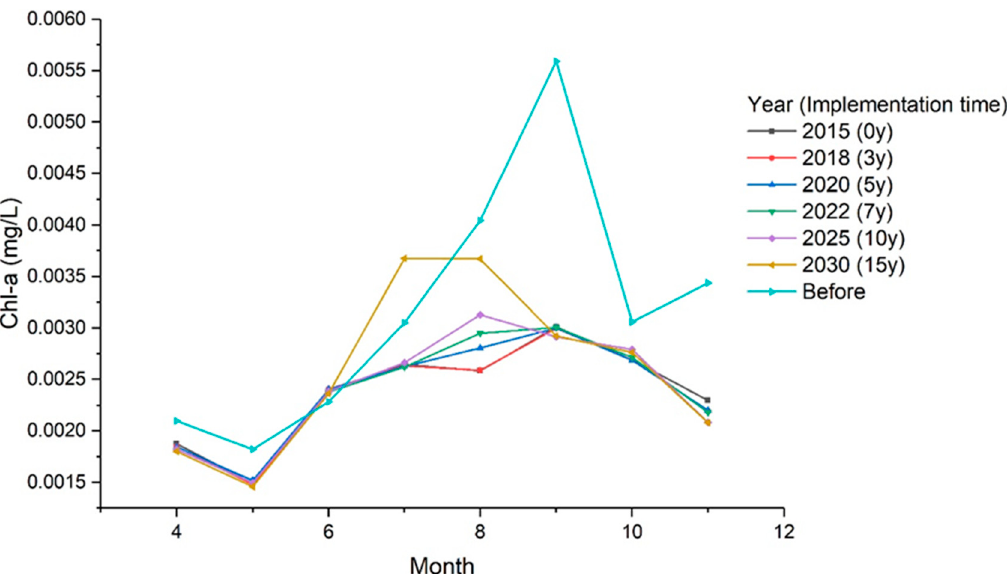
Figure 9. Annual Chl-a concentration variations of Miyun Reservoir after SNWTP implementation (before are mean concentrations from 2009 to 2014).